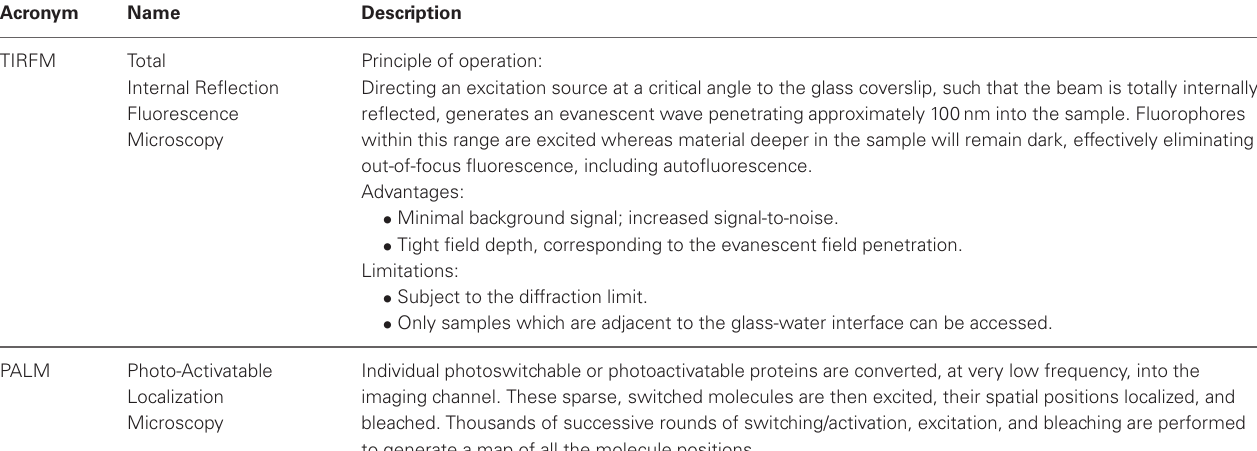
Table 1 | Advantages and limitations of TIRFM, PALM, and